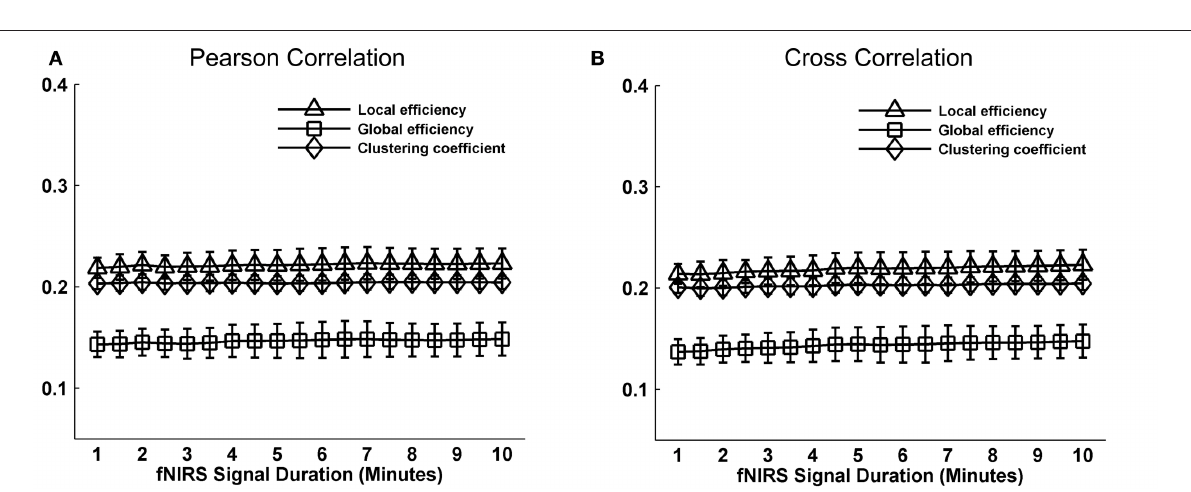
10.0 min in 30-s bins). The efficiency ∼